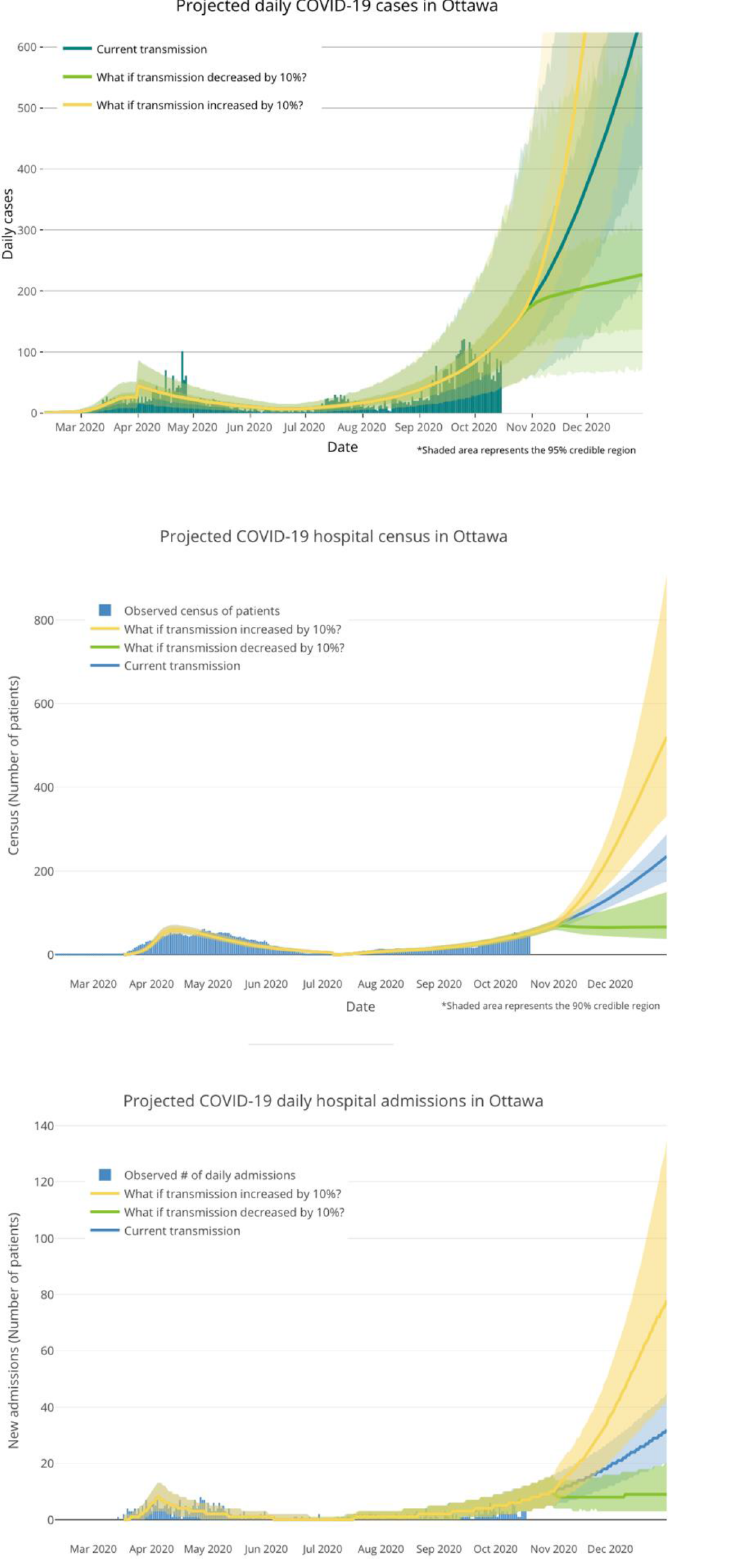
Figure 1: Ottawa covid-19 historic and projected cases, hospital census and hospital